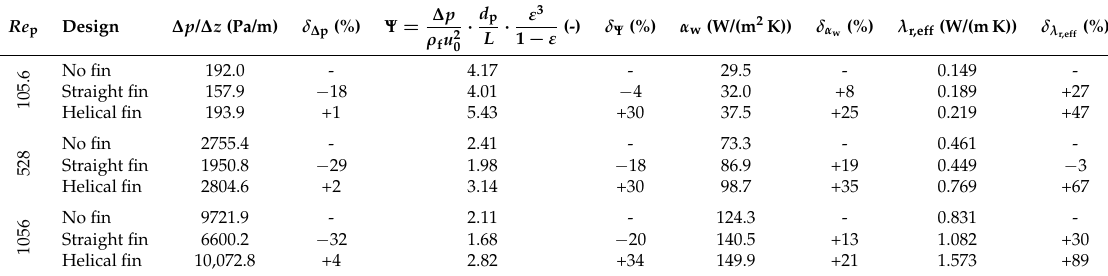
Table 4. Summary of simulation